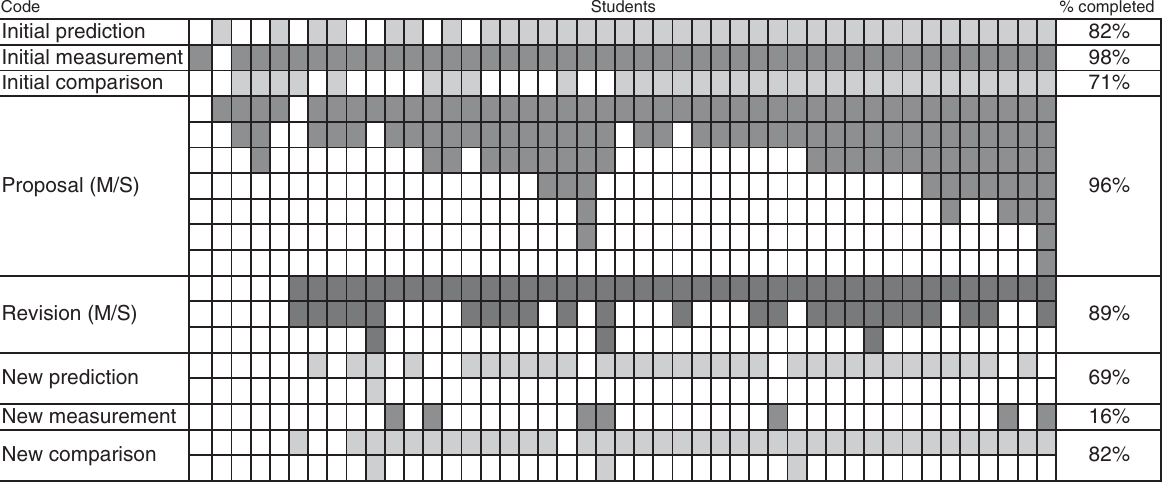
FIG. 7. Coding results for Activity 2. In total, 53% of the students completed the modeling process for the activity. Rows represent different steps in the modeling process and columns represent individual students. Each gray box represents a documented instance of the corresponding modeling step for the corresponding